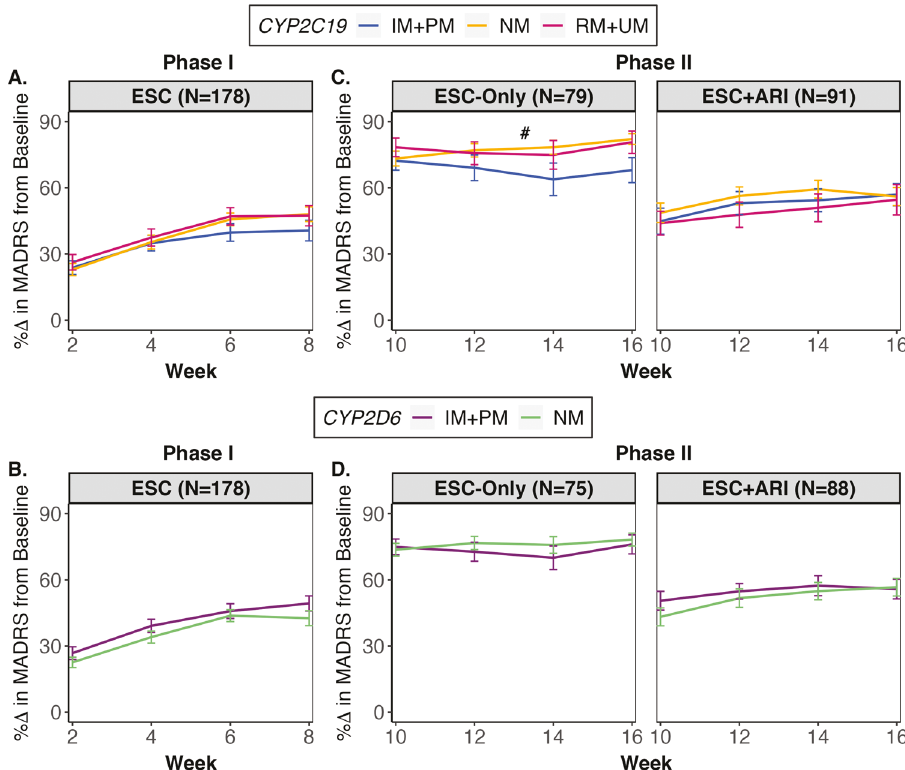
Fig. 2 Symptom improvement over time for Phase I and II by CYP2C19 and CYP2D6 metabolizer group. During Phase I, A CYP2C19 or B CYP2D6 metabolizer groups did not have a signi fi cant in fl uence on symptom improvement over time. During Phase II, for the ESC-Only treatment arm, the average symptom improvement from baseline for every two-week assessment trended towards being lower in C CYP2C19 IM + PMs compared to NMs, which was not observed in the ESC + ARI group. There were no associations between symptom improvement over the course of Phase II and D CYP2D6 metabolizer groups for any of the treatment arms. All linear mixed effects analyses were adjusted for age, ancestry, sex, and interaction between time and CYP2C19 and CYP2D6 metabolizer groups as fi xed effects, and recruitment site and subject as random effects variables. Error bars represent standard error. ARI aripiprazole, ESC escitalopram, IM intermediate metabolizer, NM normal metabolizer, PM poor metabolizer, RM rapid metabolizer, UM ultra-rapid Metabolizer. # indicates trend with q between 0.050 and groups did not show a signi fi cant association with ESC adj levels at Week 2 (Fig. 4B). For Phase II, serum levels of ESC adj were available for 153 and 152 participants at Weeks 10 and 16, respectively. In ESC-Only, there was a trend for an association between CYP2C19 metabolizer group and ESC adj concentrations for Weeks 10 ( F (2,53) = 4.98 , p = 0.013, q = 0.056, f 2 = 0.11) and 16 ( F (2,54) = 5.26 , p = 0.016, q = 0.062,